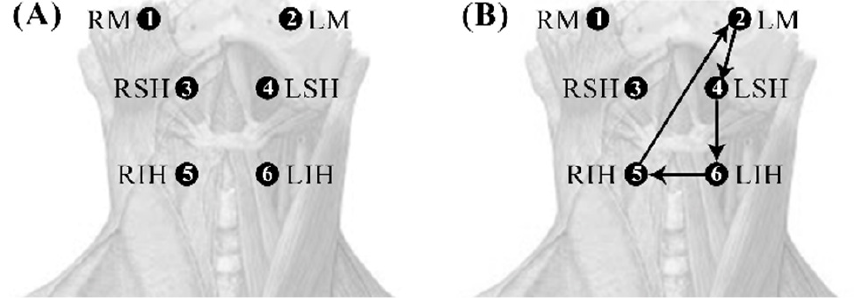
Figure 5. Schematic representations of statistically significant differences in the cG-causality of interaction pairs between healthy and dysphagic subjects for saliva ( A ), water ( B ), and yoghurt ( C ). Significantly higher and lower interactions in dysphagic subjects are shown in red and blue, respectively.